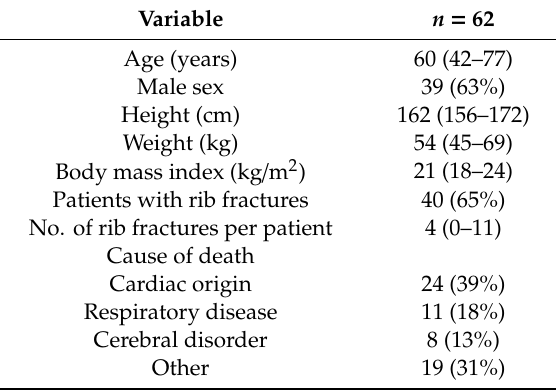
Table 1. Demographic characteristics of